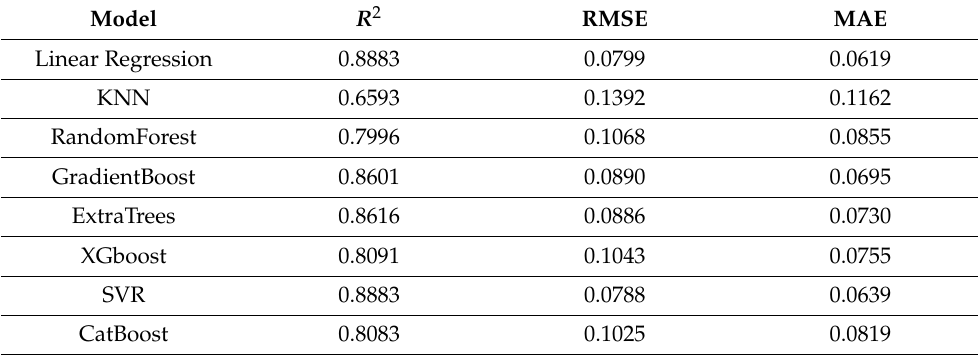
Table 9. Forecast evaluation of statistical